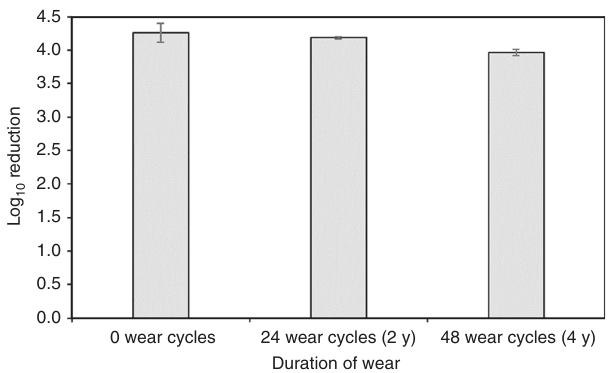
Fig. 5 Ef fi cacy of copper – glass ceramic particles after simulated wear. Plot of antimicrobial potency following washing and abrasion that illustrates longevity of copper – glass ceramic particles. Test paint coatings maintain bactericidal ef fi cacy (>99.9%) even after 4 years of simulated wear ( “ Methods ” ). Each wear cycle represents 4× washing and abrasion every month. Log reduction calculations are differences in S. aureus colony counts between control and test coupons (both subjected to wear cycles). Data and error bars represent mean and standard deviation from n = 2